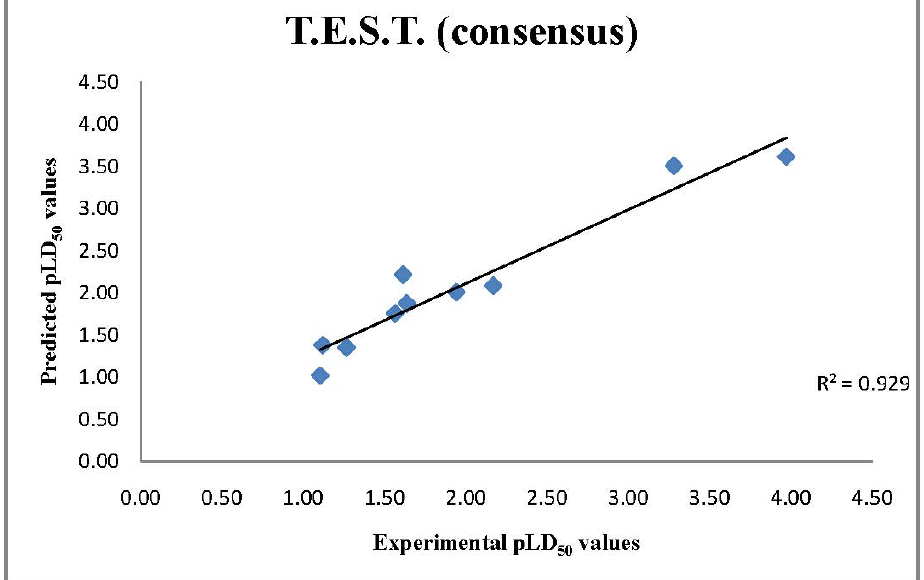
Figure 4. Comparison of Experimental pLD50 values with T.E.S.T QSAR pLD consensus model predictions.